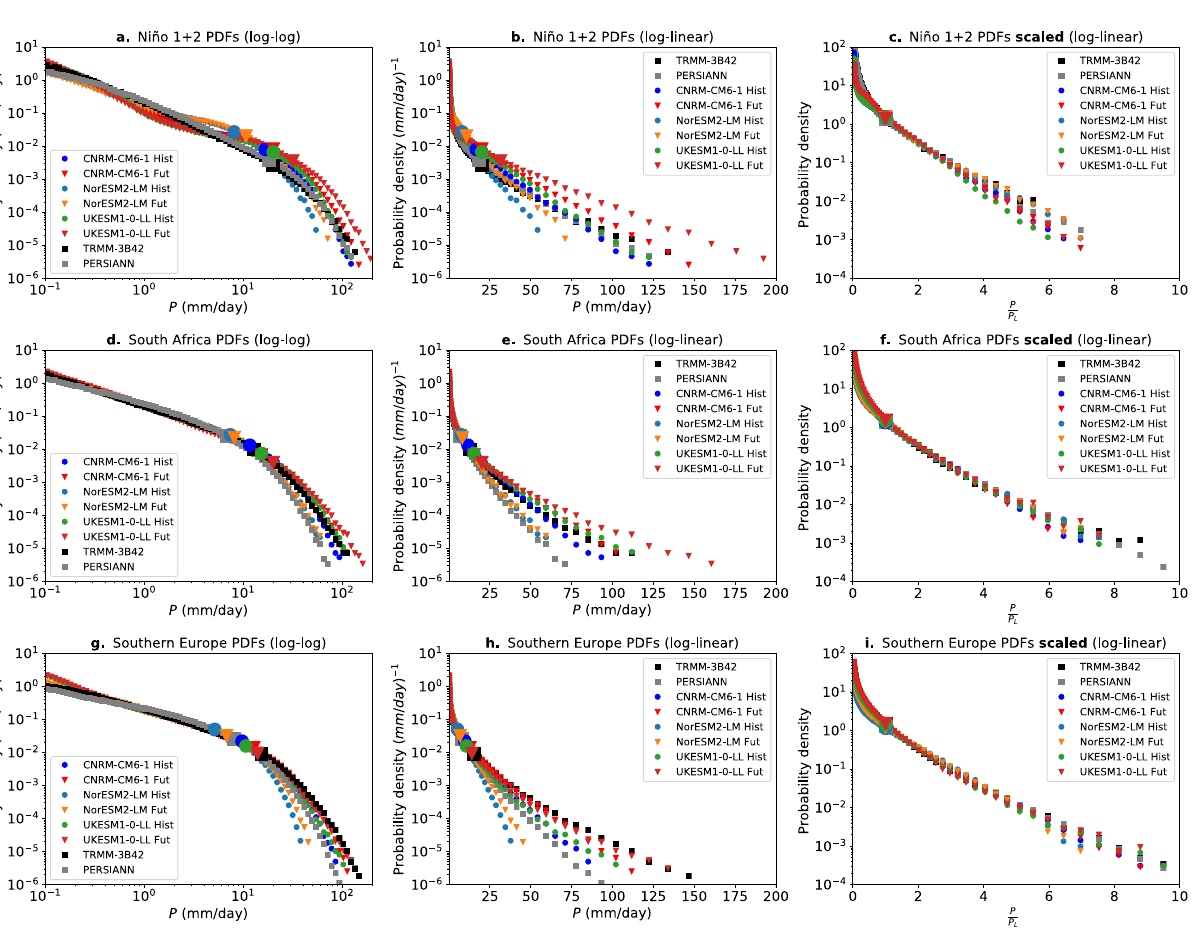
Figure 2. ( a ) Daily precipitation probability distributions in 3 models (color; CNRM-CM6-1, NorESM2-LM, UKESM1-0-LL) under historical (1990–2014) and SSP5-8.5 (2075-2099) forcing conditions in the Niño 1+2 area (10 ◦ S-0 ◦ S, 90 ◦ W-80 ◦ W). Black and gray curves show observational estimates from TRMM-3B42 40 (1998-2018) and PERSIANN 41 (1983–2017) datasets respectively. Both axes are logarithmic. ( b ) Same as ( a ) but with a linear x-axis. ( c ). Same as ( b ) but using a scaled coordinate P P . Details on the rescaling methodology L are provided in Ref. 35 . Note that for illustration purposes, here both historical and SSP5-8.5 precipitation are rescaled by their own precipitation scales P L , but to calculate the improved estimation of risk ratios (Figs. 3 and 6 ) both historical and global warming precipitation data are rescaled by the historical precipitation scale. ( d ) Same as ( a ) but over South Africa (25S–35S, 15E–30E). ( e ) Same as ( b ) but over South Africa. ( f ) Same as ( c ) but over South Africa. ( g ) Same as ( a ) but over Southern Europe (40N–50N, 0E–20E). ( h ) Same as ( b ) but over Southern Europe. ( i ) Same as ( c ) but over Southern